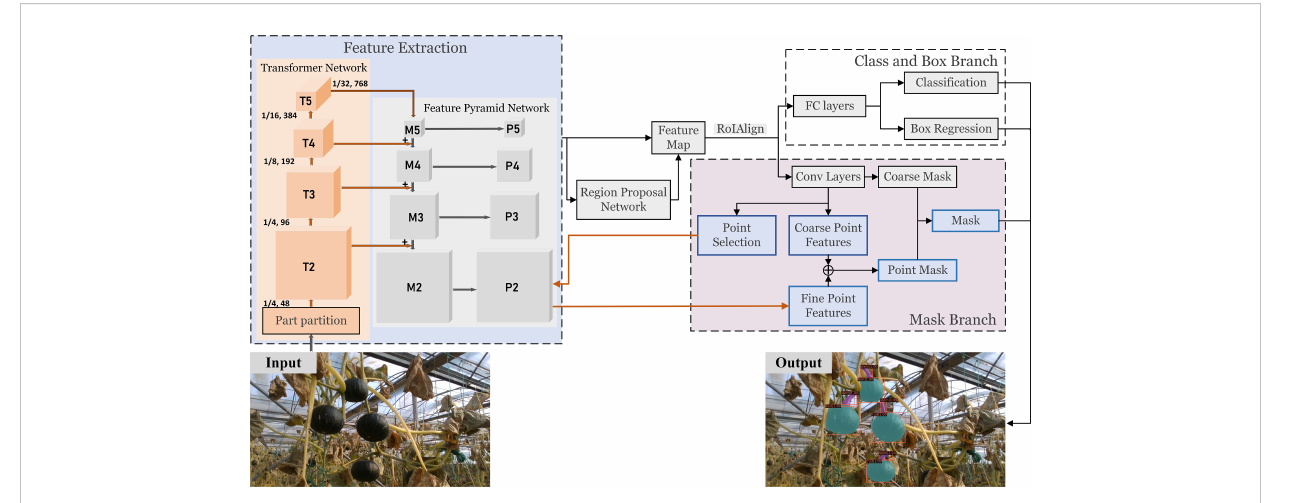
FIGURE 5 Pumpkin fruit and stem instance segmentation